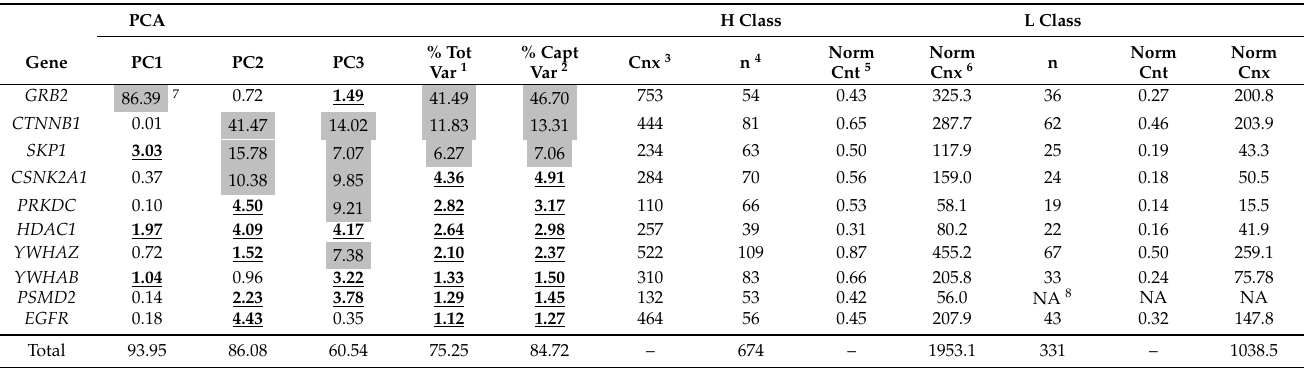
Table 3. Relative frequencies and connectivity of the upregulated genes that most contributed to PCA’s first, second, and third